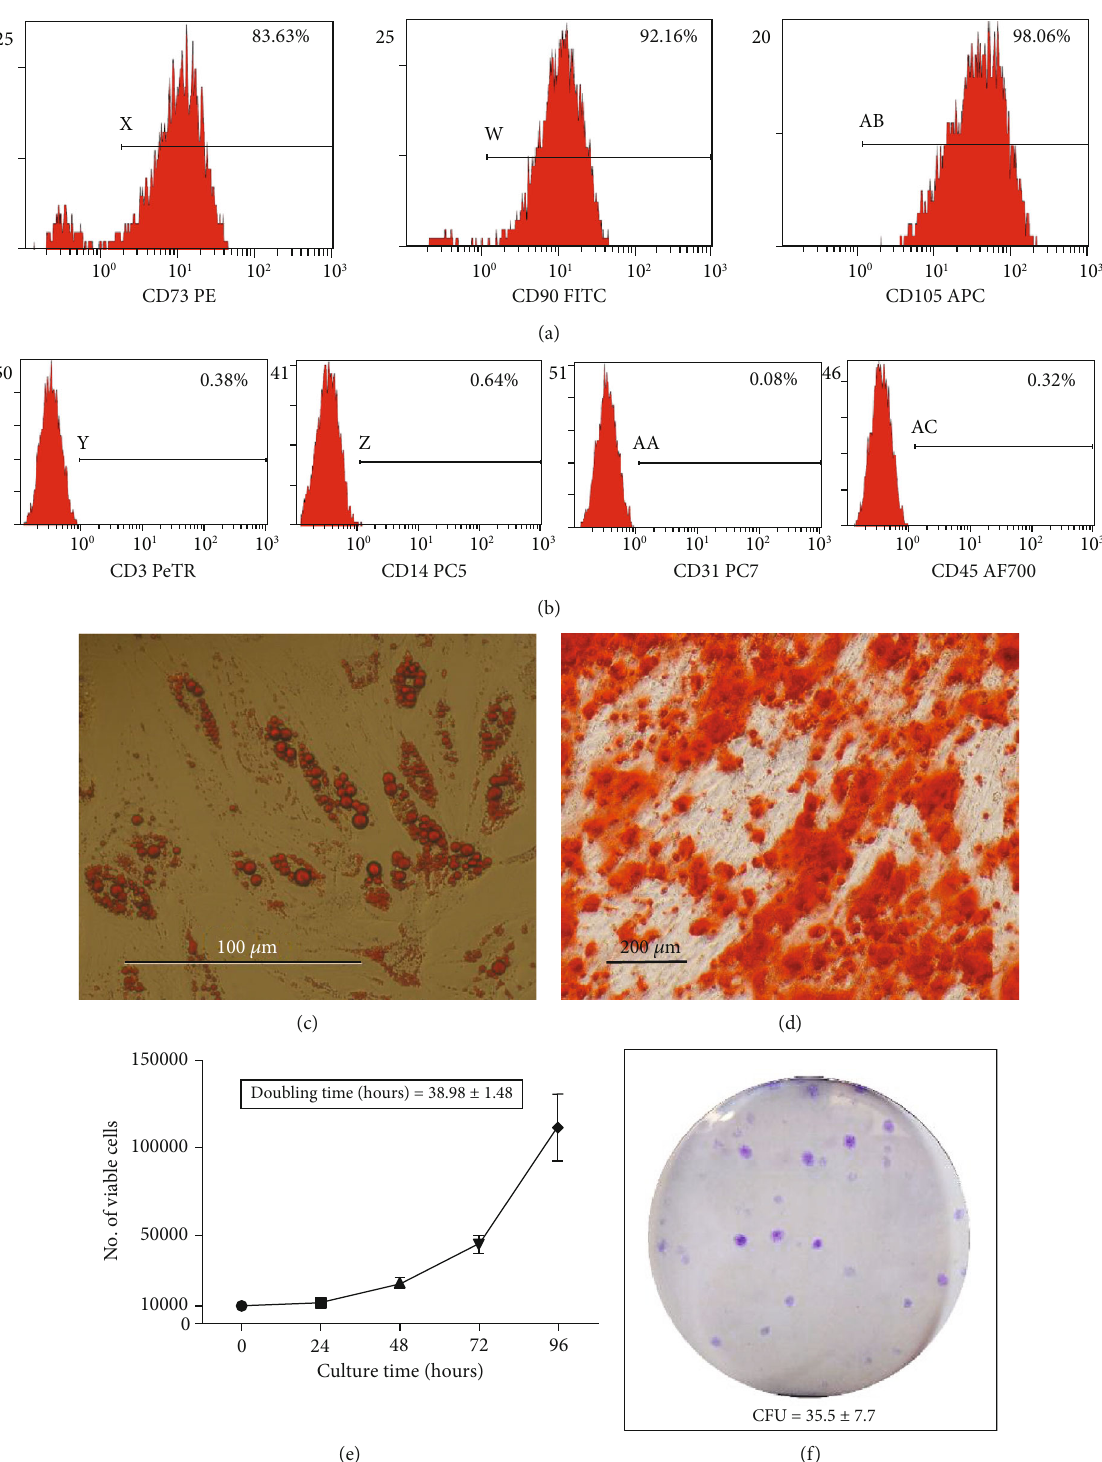
Figure 1: ASC characterization based on immunophenotype, di ff erentiation, doubling time, and CFU-F assay. (a-b) Histograms display detection of surface antigen markers; (a) Positive markers CD73, CD90, and CD105; (b) Negative markers CD3, CD14, CD31, and CD45. (c) Representative image of Oil Red O stained cells; intracellular oil droplets (red) are visible in ASCs cultured in adipogenic media for 28 days (scale bar 100 μ m). (d) Representative image of Alizarin red stained cells; mineral deposition (red) is visible around ASCs cultured in osteogenic media for 28 days (scale bar 200 μ m). (e) Proliferation curve of ASCs from 0-96 hours, mean doubling time; 38 : 98 ± 1 : 48 hours. (f) Representative image of crystal violet stained ASC colonies; 35 : 5 ± 7 : 7 CFUs were observed per 100 cells seeded on cell culture plate and cultured in stromal media for 14 days. All displayed data are derived from 3-donor-pooled; Passage 2